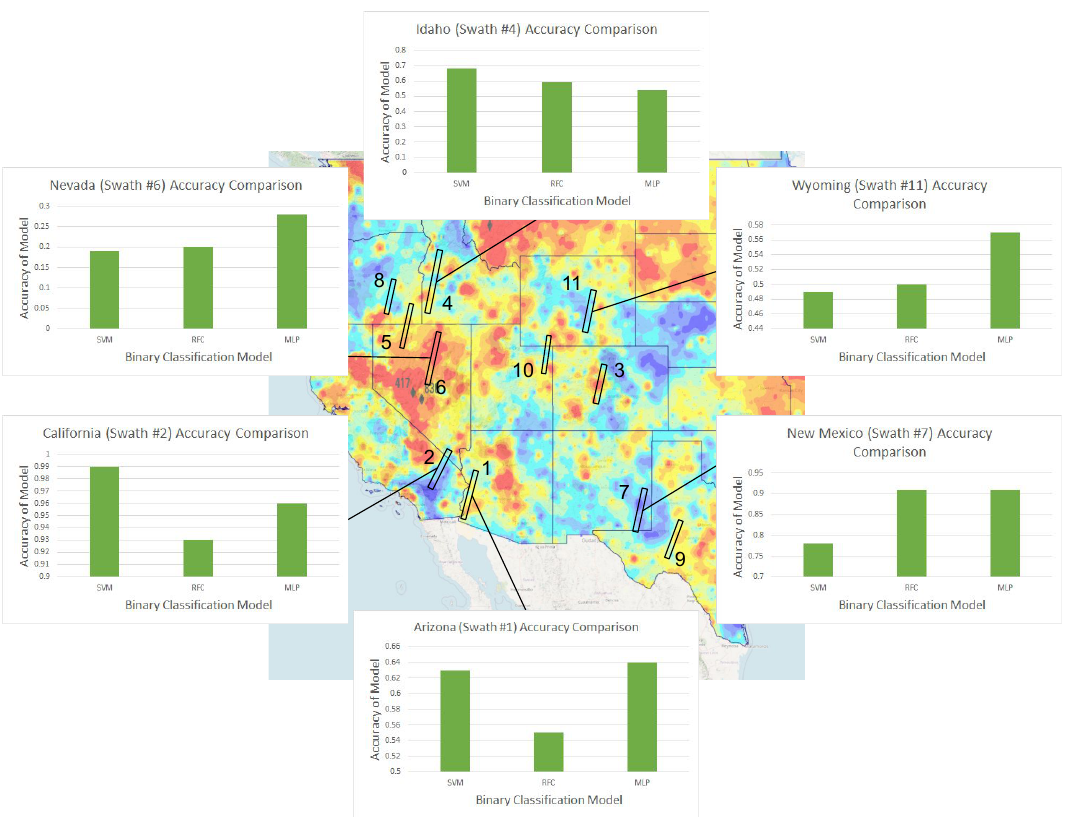
Figure 11. Comparison of accuracy of three binary classification machine learning methods for six sample swaths. Back- ground map of the western US colored by arsenic risk [49] showing the chosen 11 swaths (which yield 20,000 points) for shrub soil arsenic risk analysis (swath signatures are presented in Table 7 for public reference, being obtained from the USGS Earth Explorer platform). The results of the three binary classification machine learning models are shown as bar graphs for 6 of the 11 swaths. Accuracy values for all swaths are shown in Figure 12. Background mage created with USGS data